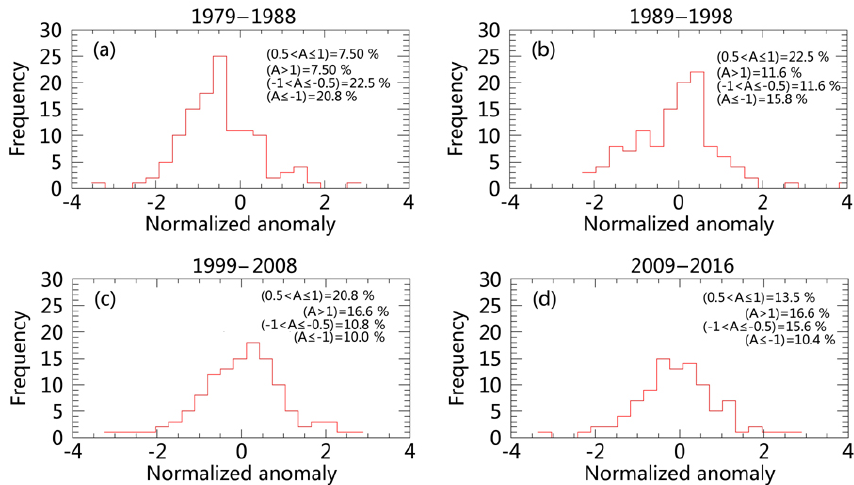
Figure 4. Frequency distribution histograms for months with different normalized anomalies in sea ice area flux in different decades. The fraction depicted as the percentage for each period, for example, (0 . 5 < A ≤ 1) = 7 . 5% as presented in panel (a) , refers to the ratio between the frequency of the months sorted into the outlined range and the total number of months during the examined decades.